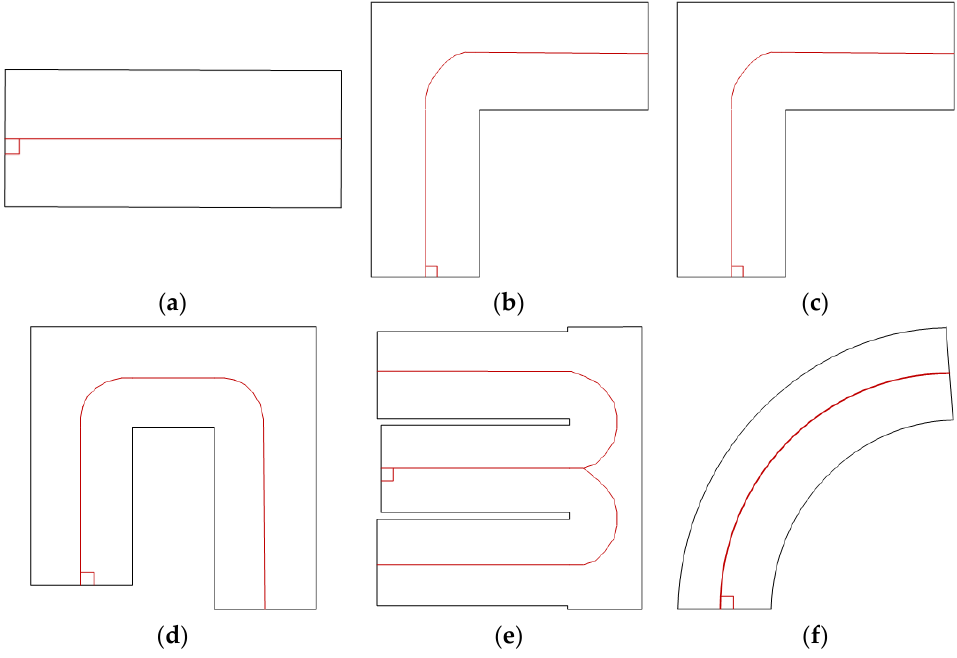
Figure 16. The generations of X-Z topological paths for the evaluated stairs: ( a ) straight stair, ( b ) turn stair, ( c ) L-style stair, ( d ) n-style stair, ( e ) m-style stair, and ( f ) spiral stair.